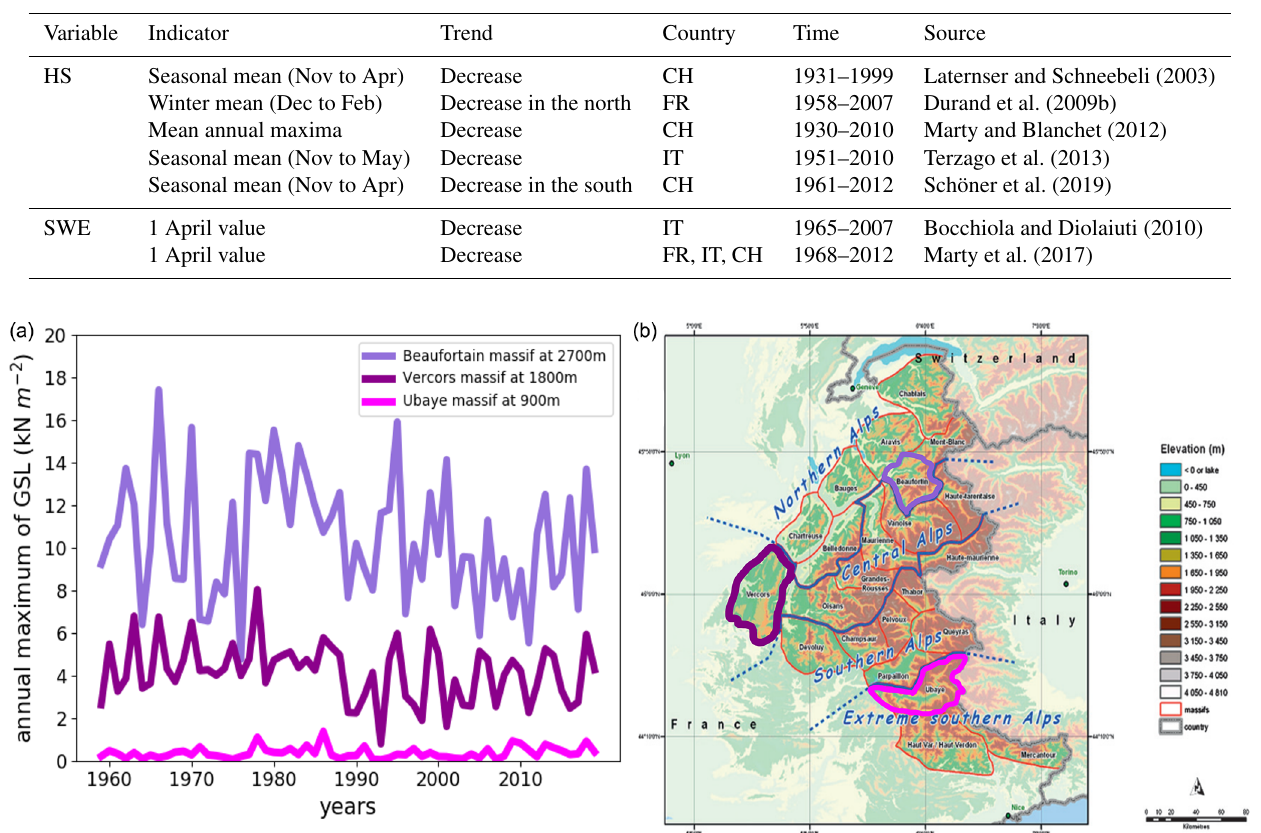
Figure 1. (a) Three time series of annual maxima of ground snow load (GSL) from 1959 to 2019 for 3 massifs at low (900m), mid (1800m) or high (2700m) altitude and (b) 23 mountains massifs of the French Alps and their orographic features (Durand et al., 2009a).